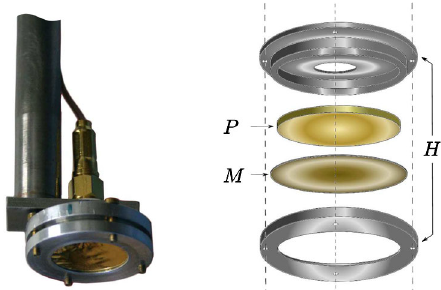
FIG. 6. OST mounted horizontally on the support tube (left) and detail drawing (right) with H ¼ housing, M ¼ porous mem- brane, and P ¼ immobile brass plate.